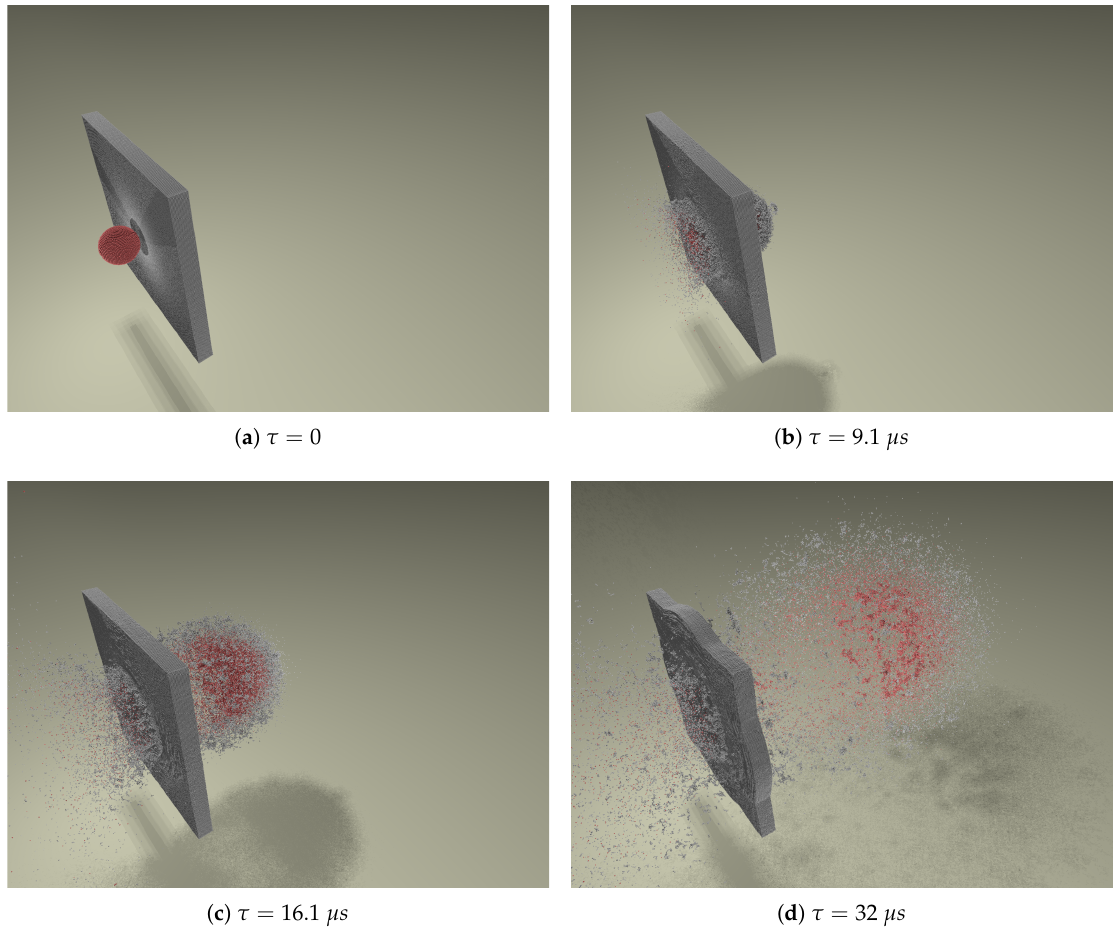
Figure 12. A series of 3D simulation snapshots showing an aluminum sphere impacting an aluminum plate at hypervelocity. Red indicates impactor particles and gray indicates target plate particles. The simulation was run with N = 7.4 × 10 5 particles, with a timestep of ∆ t = 1 × 10 − 10 s, and took nine hours to complete on a single processor. Impact parameters are: v 0 = 6.7 kms − 1 and t / D = 0.425. A video sequence of this simulation can be found as Supplementary Material in Video